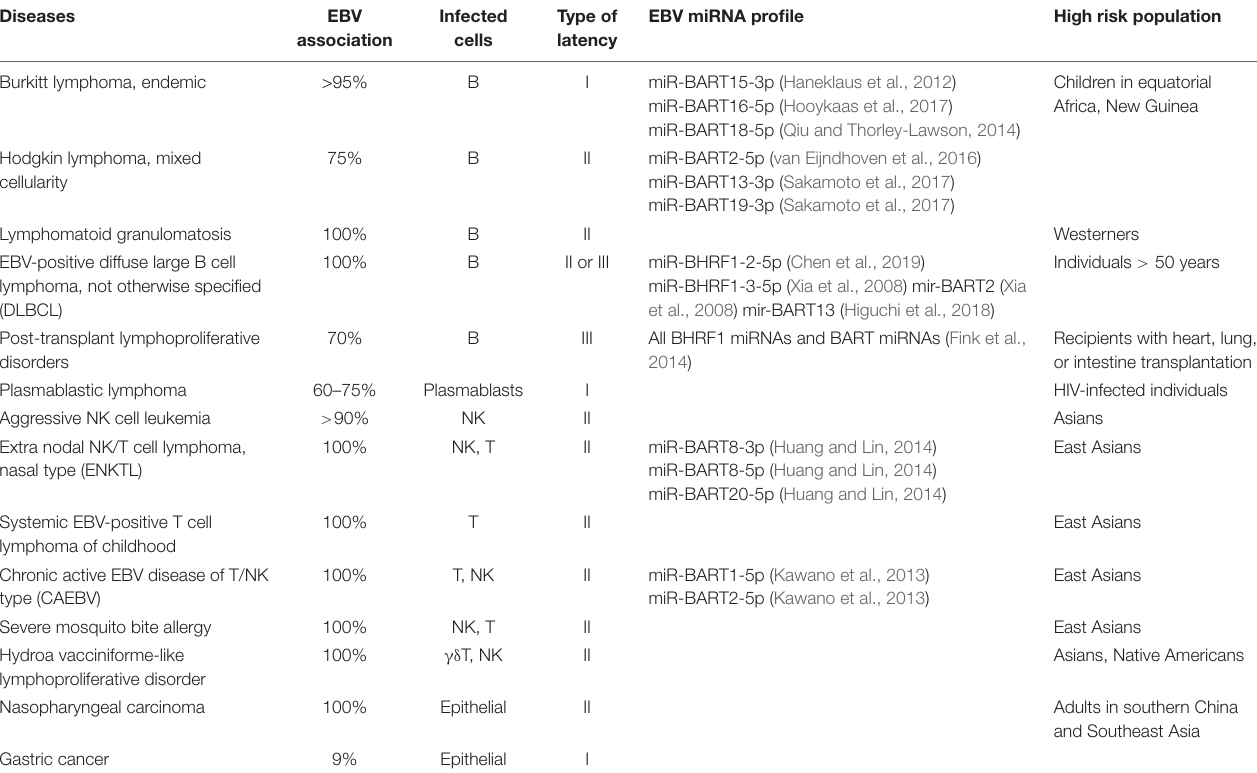
TABLE 1 | Representative EBV-associated malignancies and their